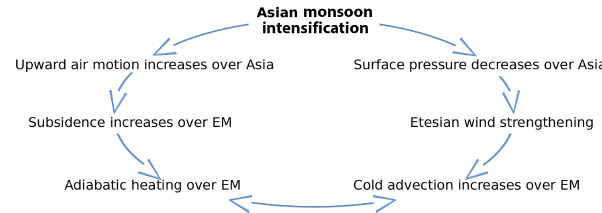
Figure 8. Schematic of the proposed mechanism during intensifica- tion of the Asian monsoon (reproduced from Ziv et al., 2004).